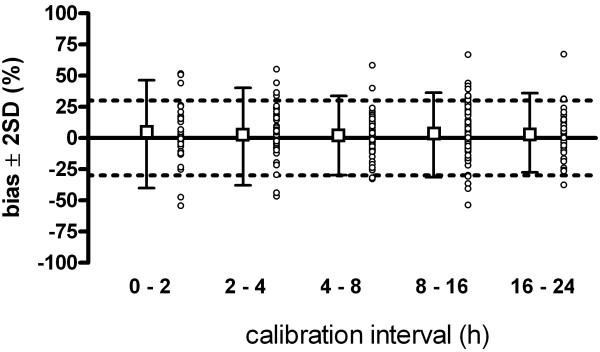
Bias in relation to time interval between calibrations. Mean bias (boxes) ± limits of agreement and individual bias (circles) expressed as percentage of COTCP between PCCO and COTCP in subsets of different calibration intervals. Dotted lines illustrate interchangeability (±30%).